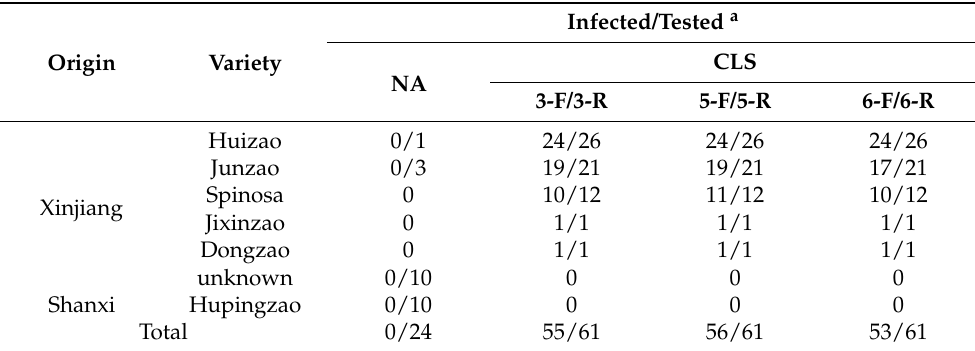
Table 3. Incidence of JYMaV in the jujube leaf samples collected from Aksu area in Xinjiang Uygur Autonomous region and Shanxi Province of China by RT-PCR using three primer sets.